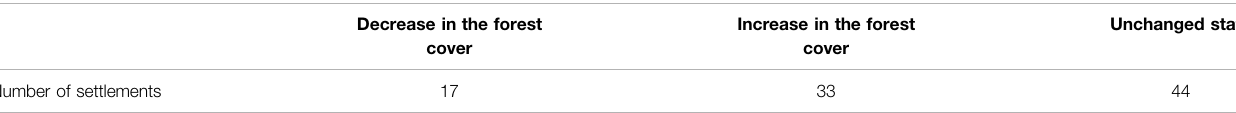
TABLE 1 | The number of settlements based on changes in the forest cover from 1990 to 2018.